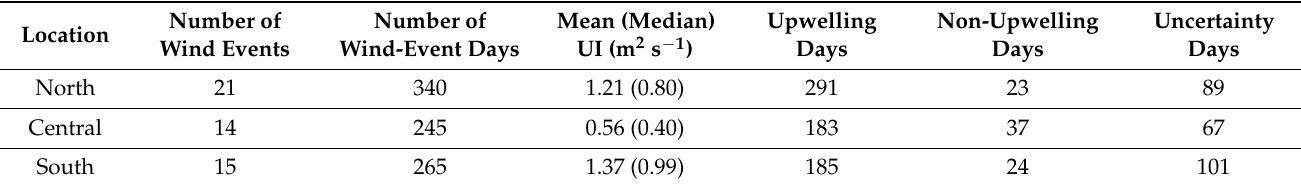
Table 2. The statistics of the significant upwelling-favorable wind events and the mapping of coastal upwelling at the three locations of east Taiwan, during the five extended summer seasons (May to September) between 2015 and 2019.